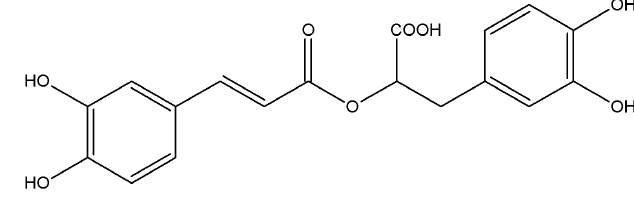
Figure 8. Chemical structure of RA.